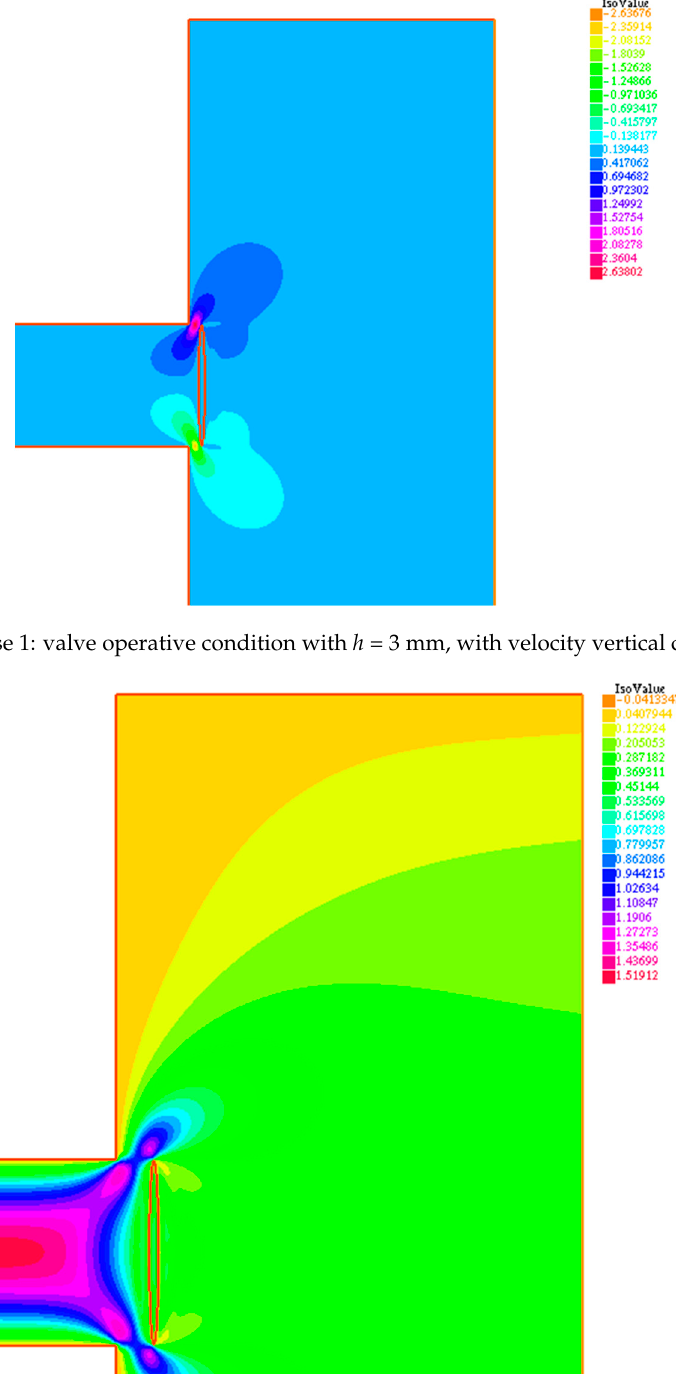
Figure 5. Case 1: valve operative condition with h = 3 m, with velocity horizontal component u .